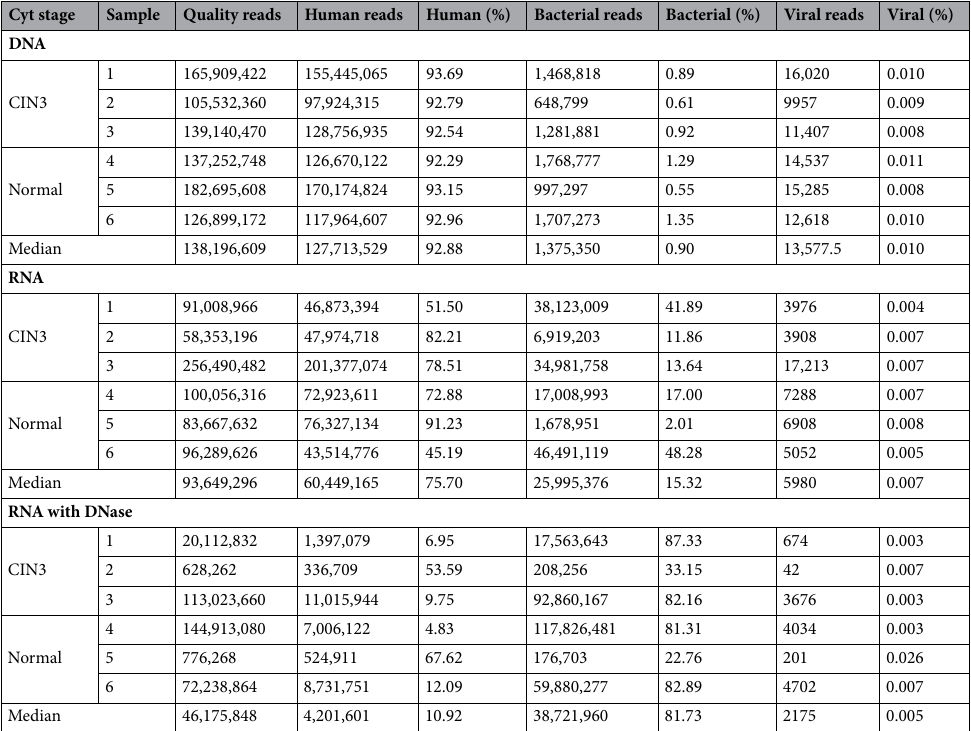
Table 1. Distribution and classification of high-quality reads among the cervical liquid-based cytology normal and cervical intraepithelial neoplasia 3 (CIN3) swab specimens. Cyt stage = Cytology stage, CIN3 = cervical intraepithelial neoplasia stage 3, reads = number of generated raw DNA sequences from the sequencing.